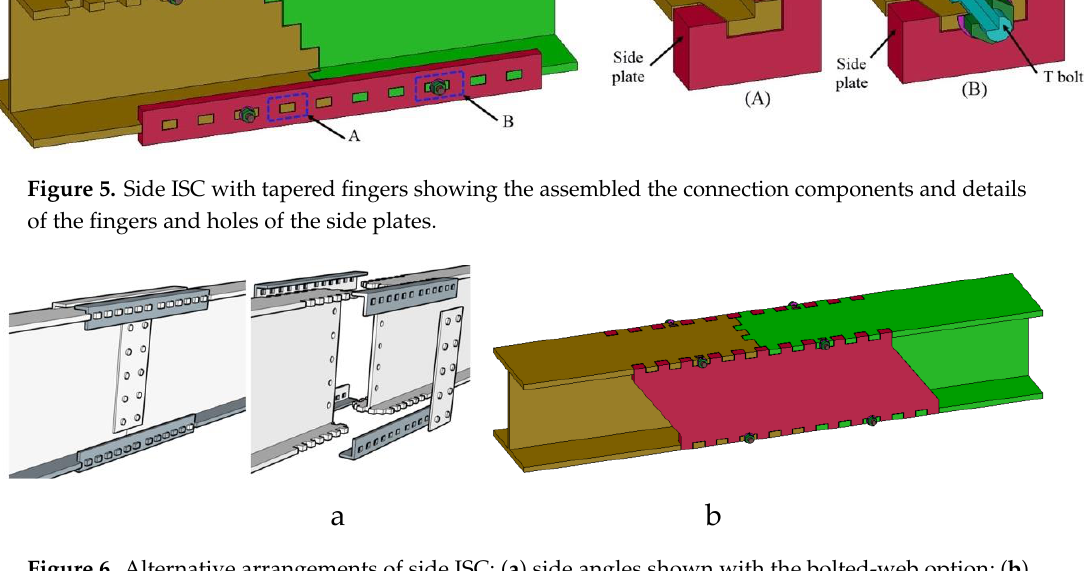
Figure 6. Alternative arrangements of side ISC: ( a ) side angles shown with the bolted-web option; ( b ) single side plates.